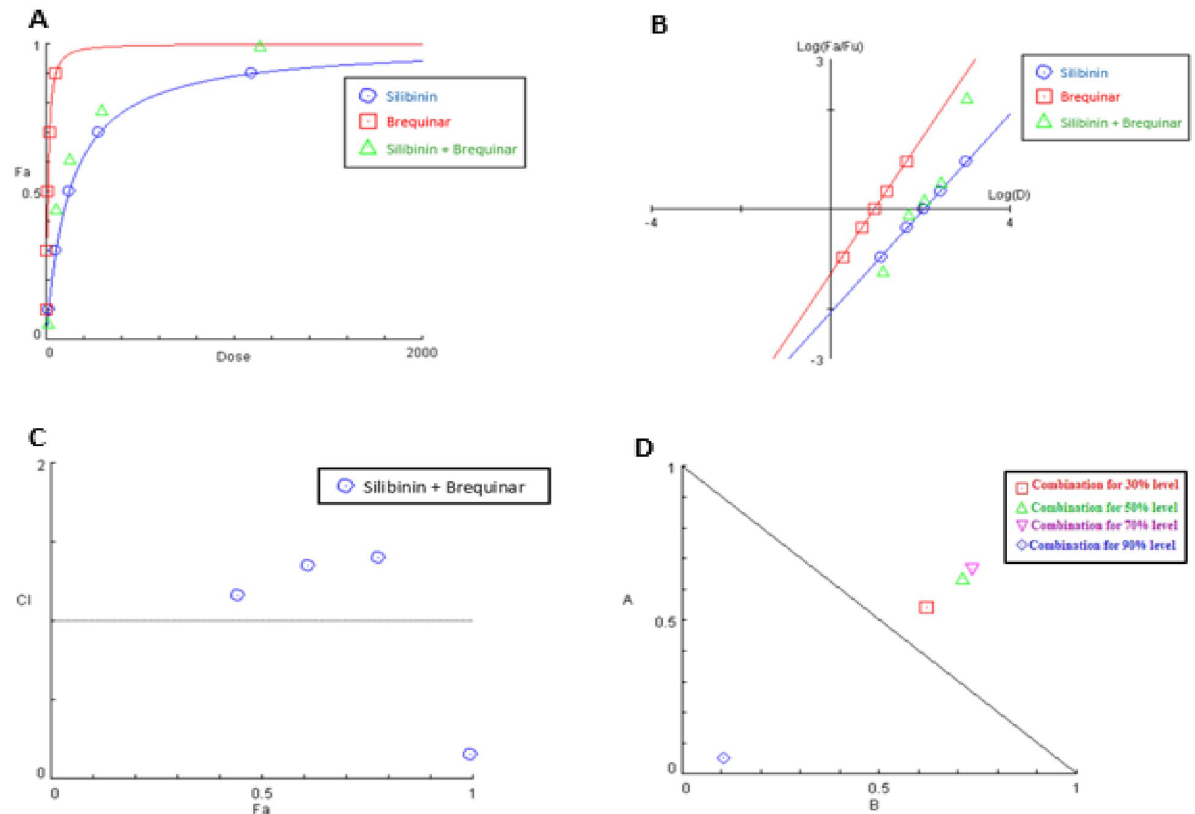
Figure 12. Analysis of silibinin and brequinar combination: ( A ) dose-effect curve and its linearization ( B ) median-effect plot for each single drug and combination treatment (C) combination index plot and ( D ) dose- normalized isobologram for various effects (10%, 30%, 50%, 70 and 90%) in the combinations of silibinin and brequinar.